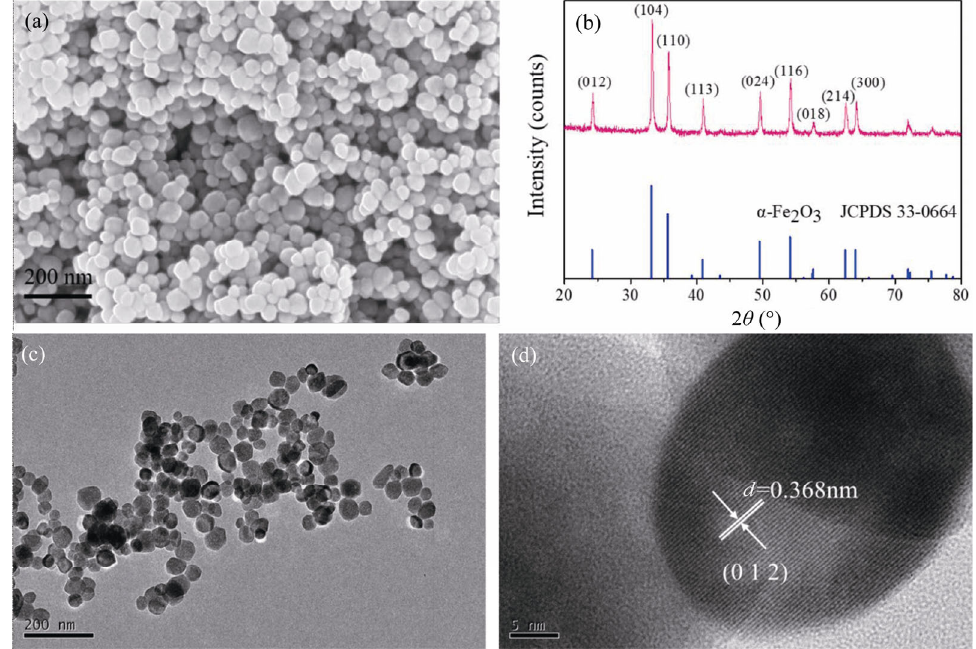
Fig. 2 (a) SEM image of the as-prepared α-Fe 2 O 3 nanoparticles and (b) XRD pattern of the samples; (c) TEM and (d) HRTEM images of the